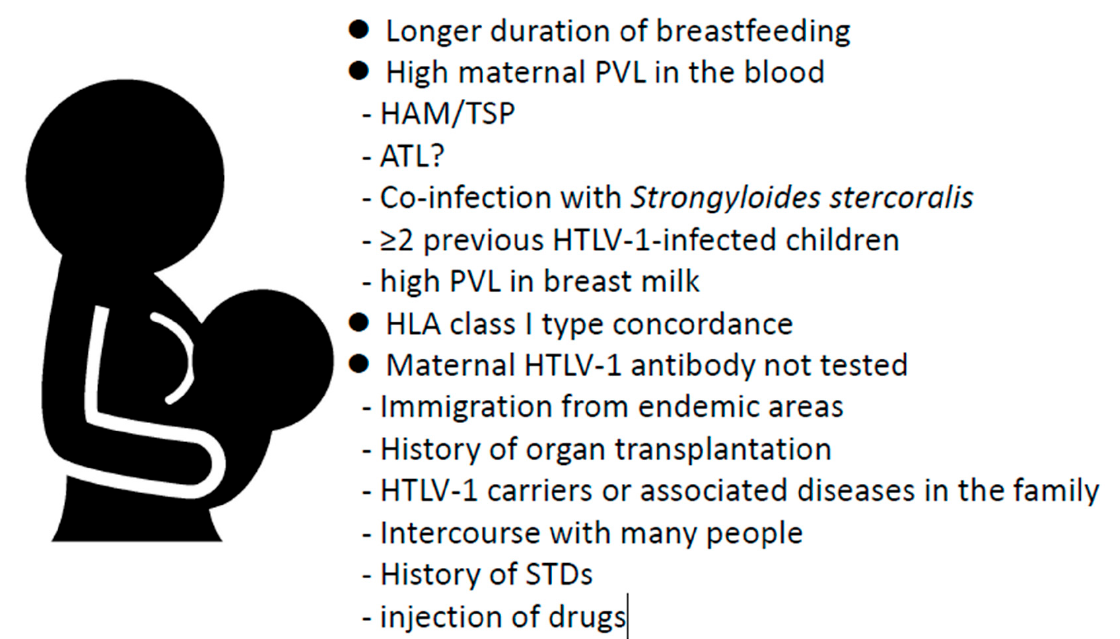
Figure 1. Risk factors associated with development of HTLV-1 mother-to-child transmission. Risk factors for mother-to-child transmission are broadly classified as long-term breastfeeding, high PVL in carrier mothers, HLA class type 1 concordance between mother and child, and mothers with untested HTLV-1 antibodies. HLA, human leukocyte antigen.